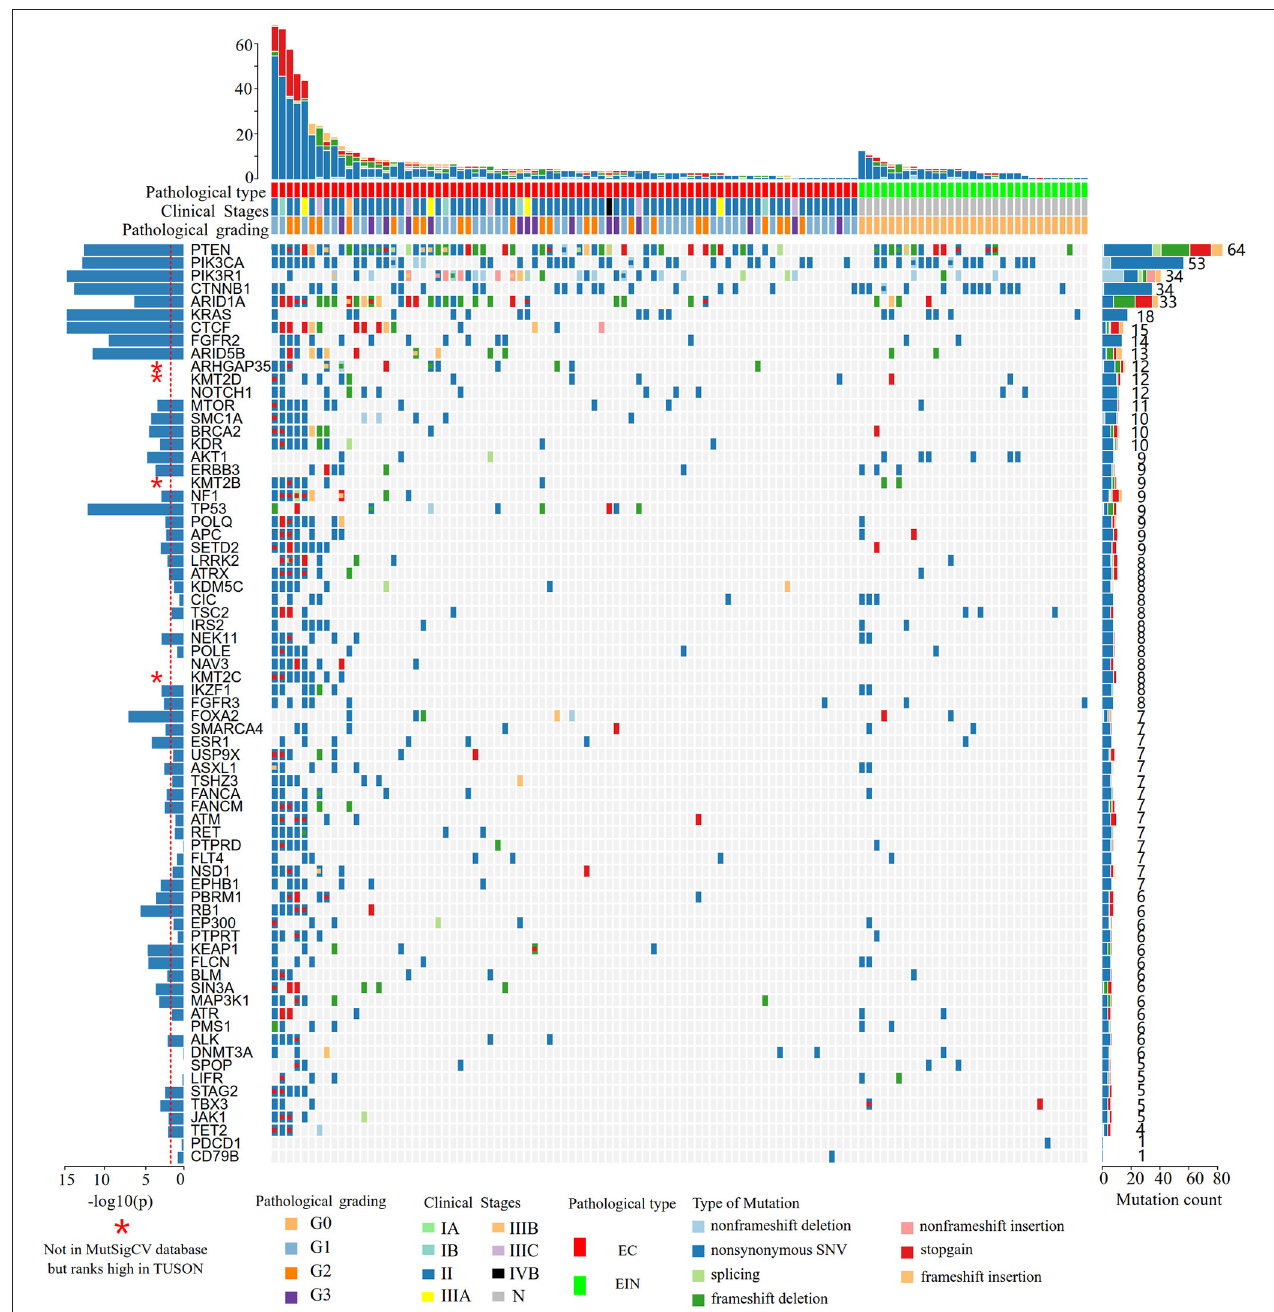
FIGURE 2 | Heat map showing somatic mutation profiles of EIN and EEC. Top, the number of different types of mutations in each sample. Middle, mutated genes are ranked based on the mutation frequency. Left, significance levels ( P -values) of each gene predicted to be drive gene by MutSigCV. The red dotted line indicates that the P -value is 0.01, and the bar above the line indicates that the P < 0.01. Right, the frequency of each mutated gene in all samples. EIN, endometrial intraepithelial neoplasia; EEC, endometrioid endometrial carcinoma.